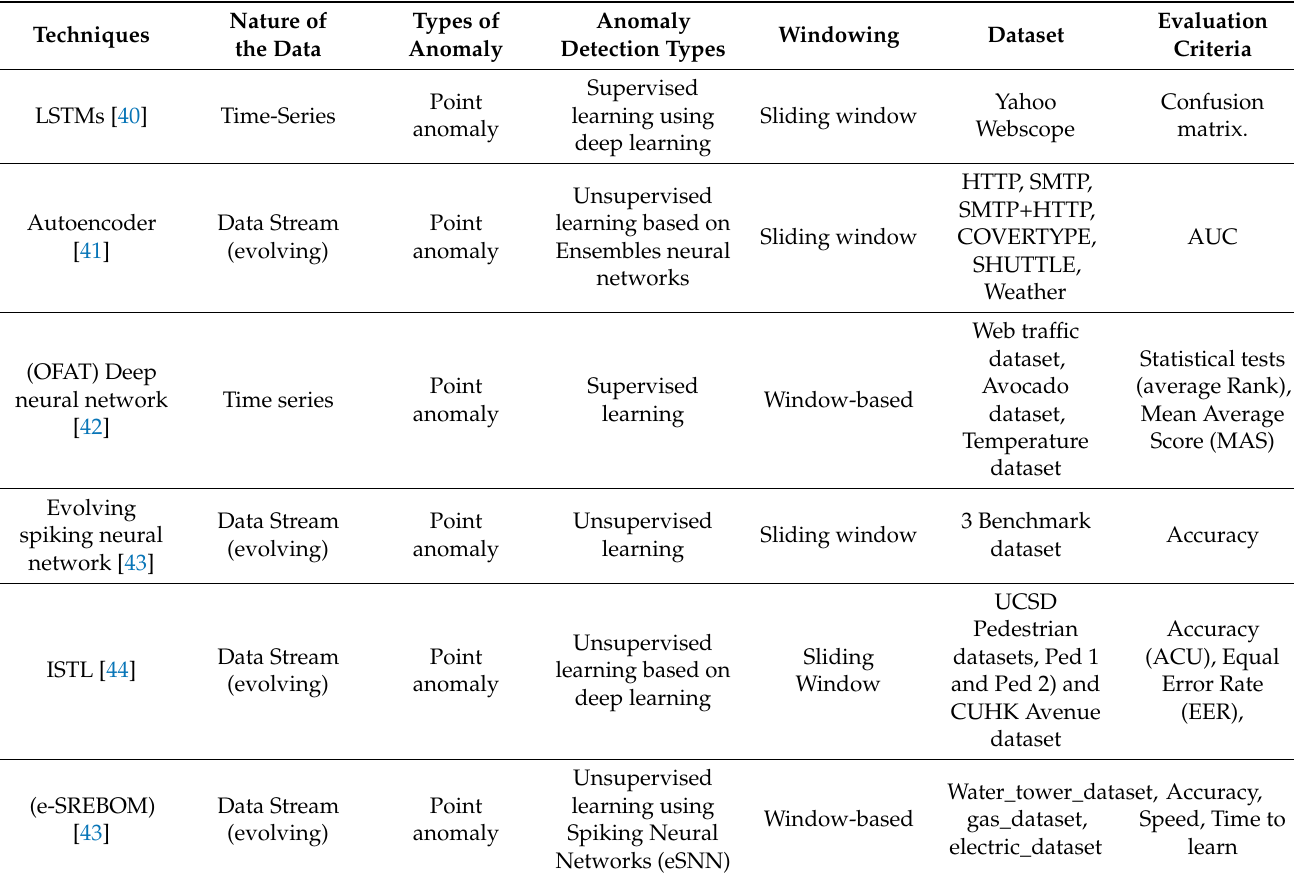
Table 2. Summary of deep learning techniques for data stream anomaly